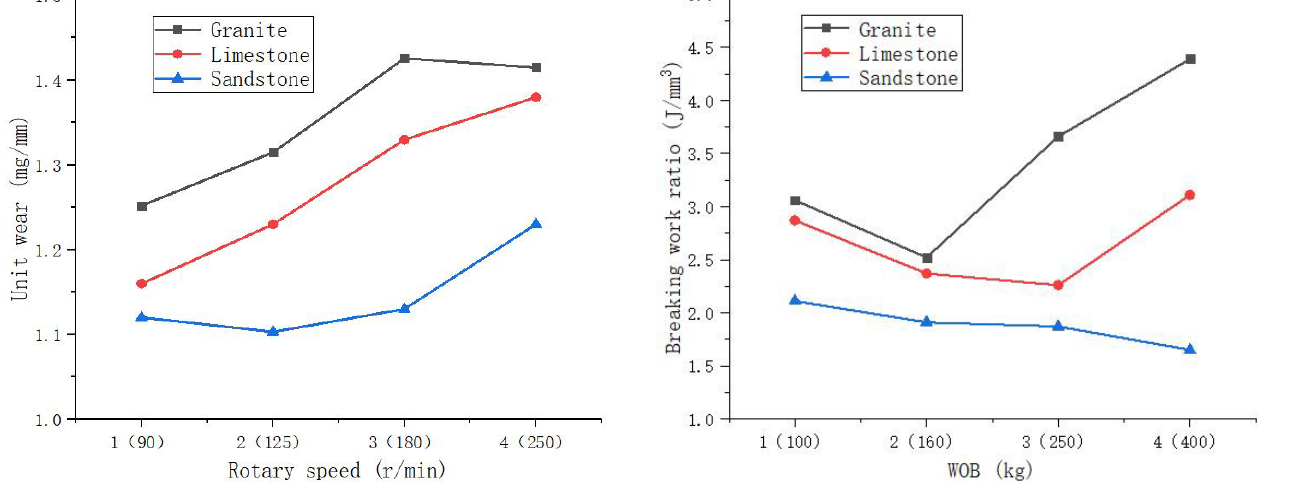
Figure 13. The relation curve between unit wear and rotary speed. Figure 14. The relation curve between unit wear and